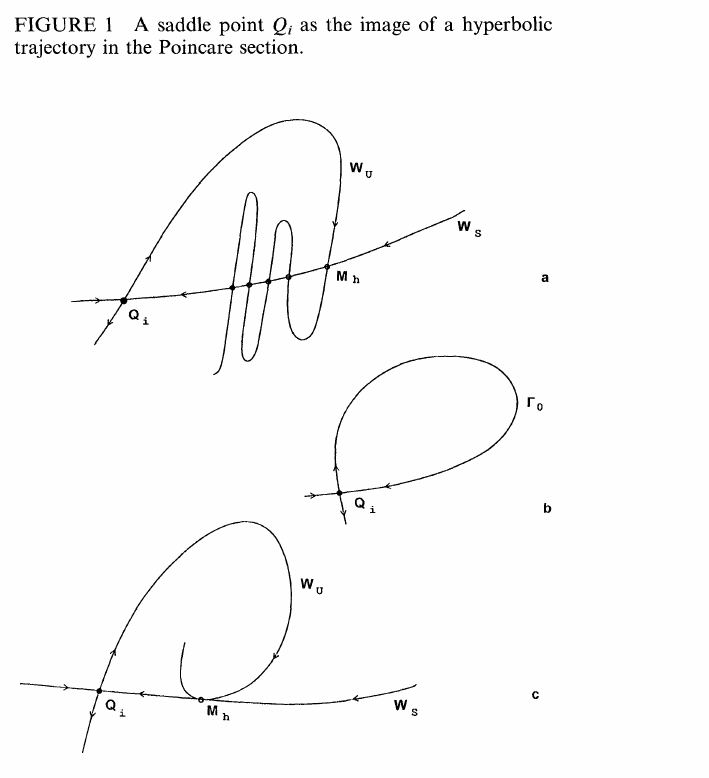
FIGURE 2 Three possible cases of the intersection of the stable and unstable separatrixes of the saddle point Qi in the Poincare